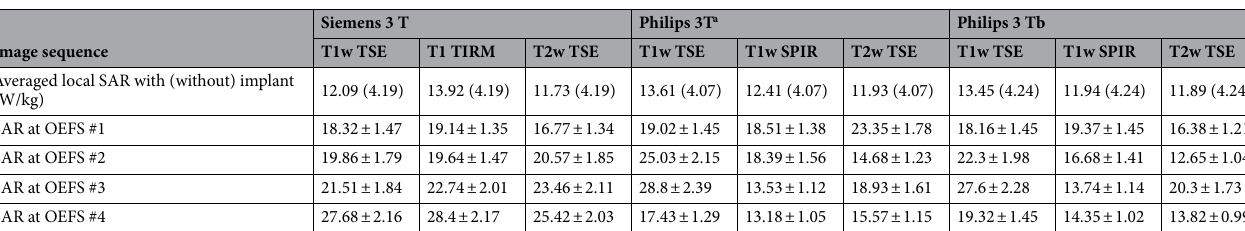
Table 2. Experimentally measured SAR (mean ± SD) using four optical E-field sensors at Siemens 3 T and two of same model Philips 3 T systems the average of the local SAR measurements with and without artificial hip joints at all locations from the head to the tail of the implants. a, b = two same model Philips 3 T MRI systems, SD = standard deviation, TIRM = turbo inversion recovery magnitude, SPIR = spectral pre-saturation with inversion recovery, TSE = Turbo spin